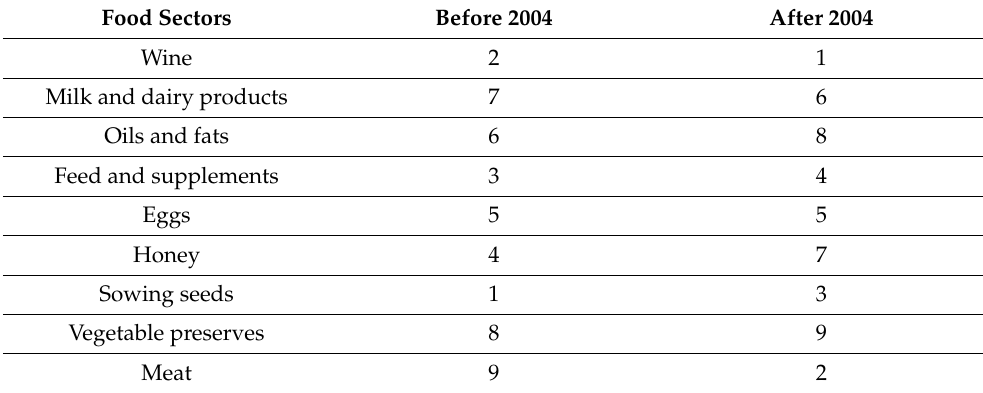
Table 5. NPC ranking for food sectors before and after